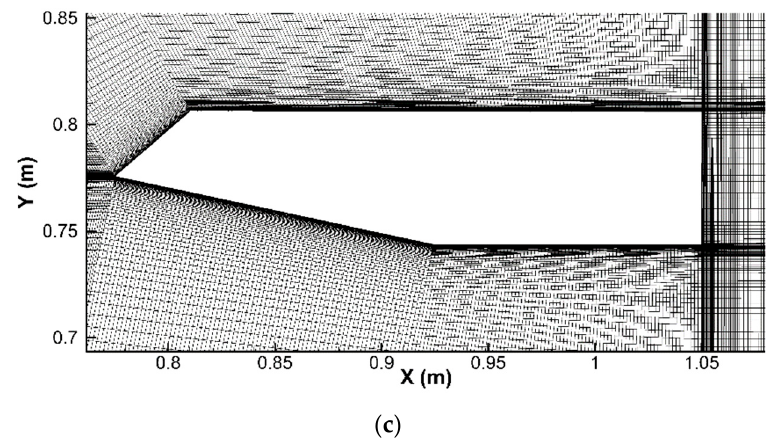
Figure 4. An example of the mesh for the case of AoA = +0.1° with 288,034 elements: ( a ) entire computational domain, ( b ) grids around the decks and ( c ) grids near the windward deck.